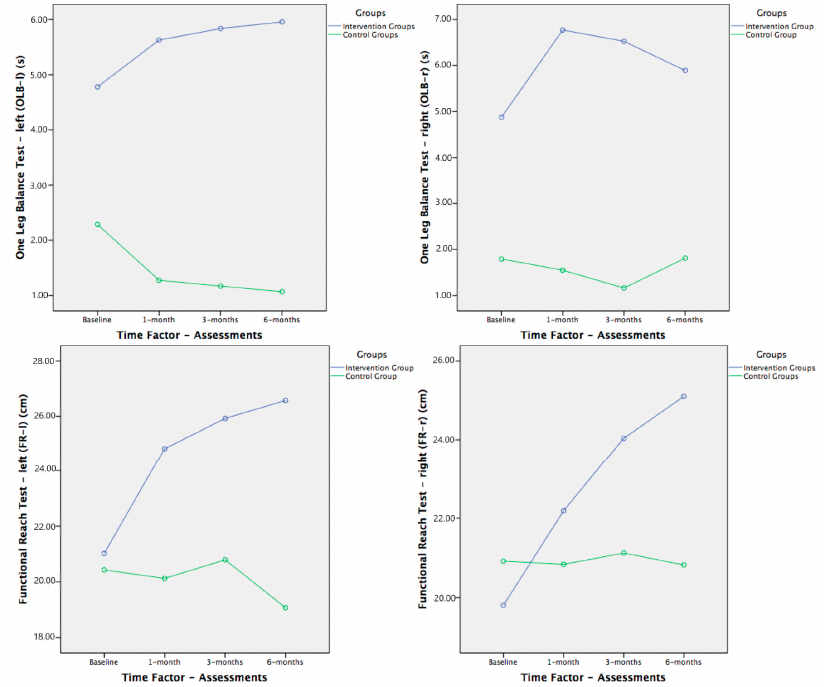
Figure 4. Within-group behavior and follow-up of one-leg balance (OLB) and functional reach (FR) tests. Comparisons between both groups (significant models in MANOVA analysis for OLB test shown in Tables 2 and 3, and no significant models in MANOVA analysis for